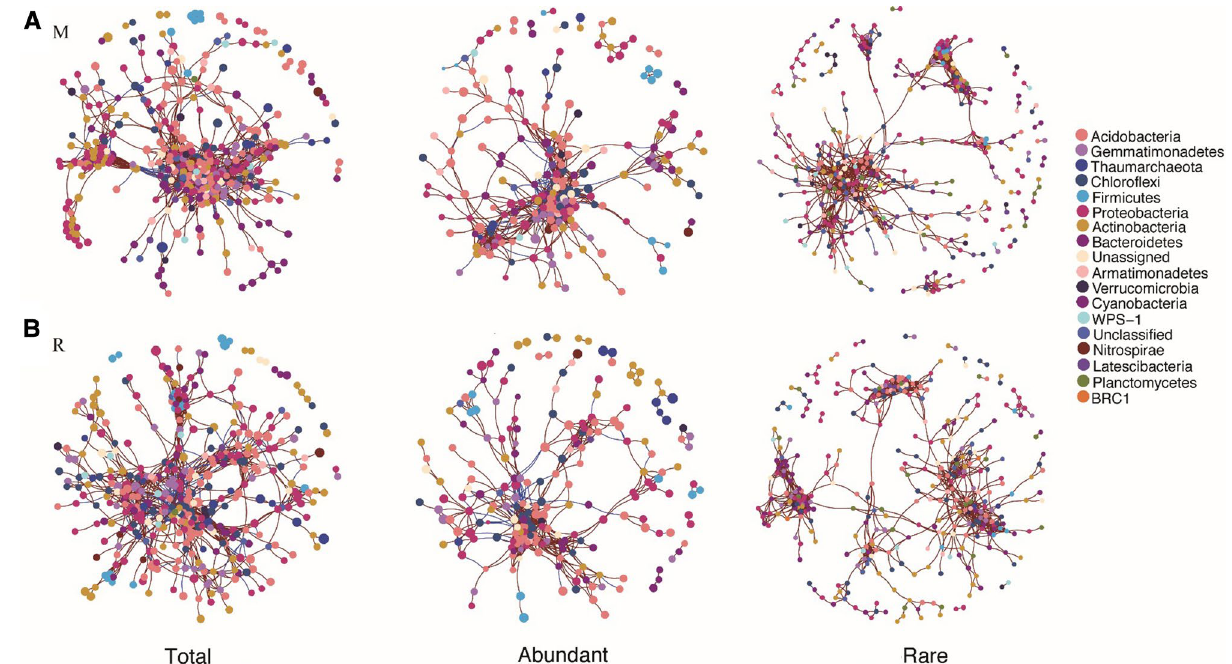
Figure 5. Co-occurrence network analysis of bacterial communities for the total, abundant and rare species (class level) in soil of tobacco monoculture ( A ) and tobacco-rice rotation ( B ). The red and blue colour of each connection between two nodes is positive and negative relationships of Spearman’s correlation